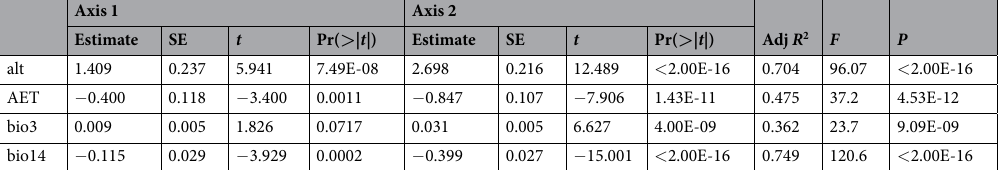
Table 4. The general linear model (GLM) for testing the correlation of the constraint variables with the first two ordination axes of